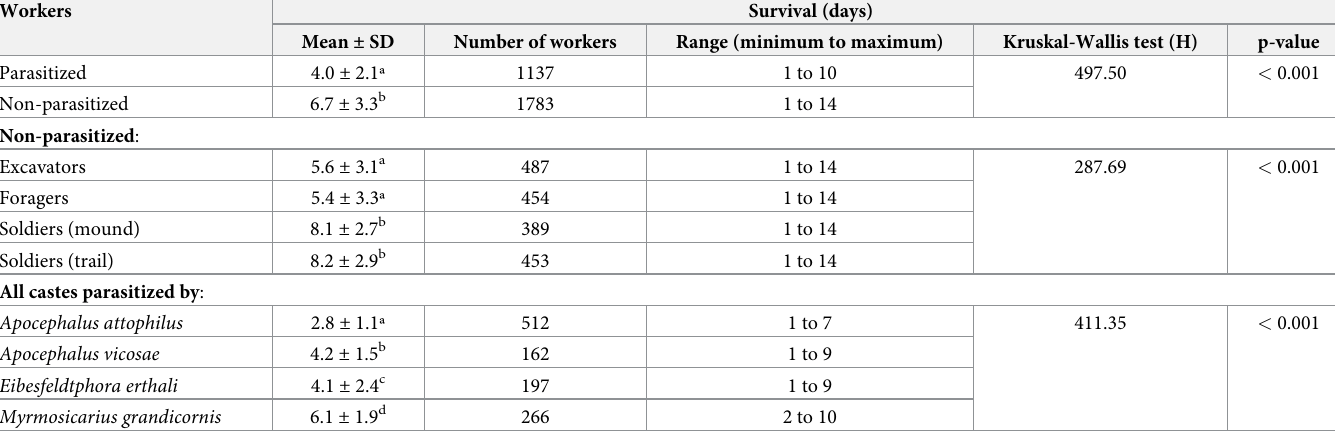
Table 2. Mean survival times of parasitized and non-parasitized Atta laevigata workers, survival times of different non-parasitized castes and worker survival time in relation to phorid species.